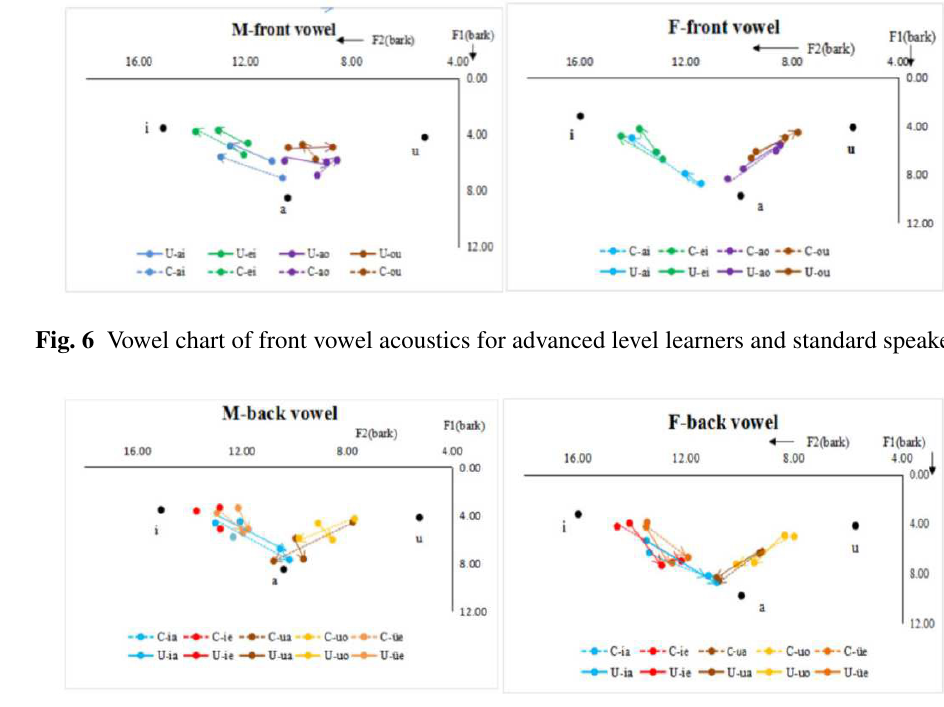
Fig. 7 Vowel chart of back vowel acoustics for advanced level learners and standard